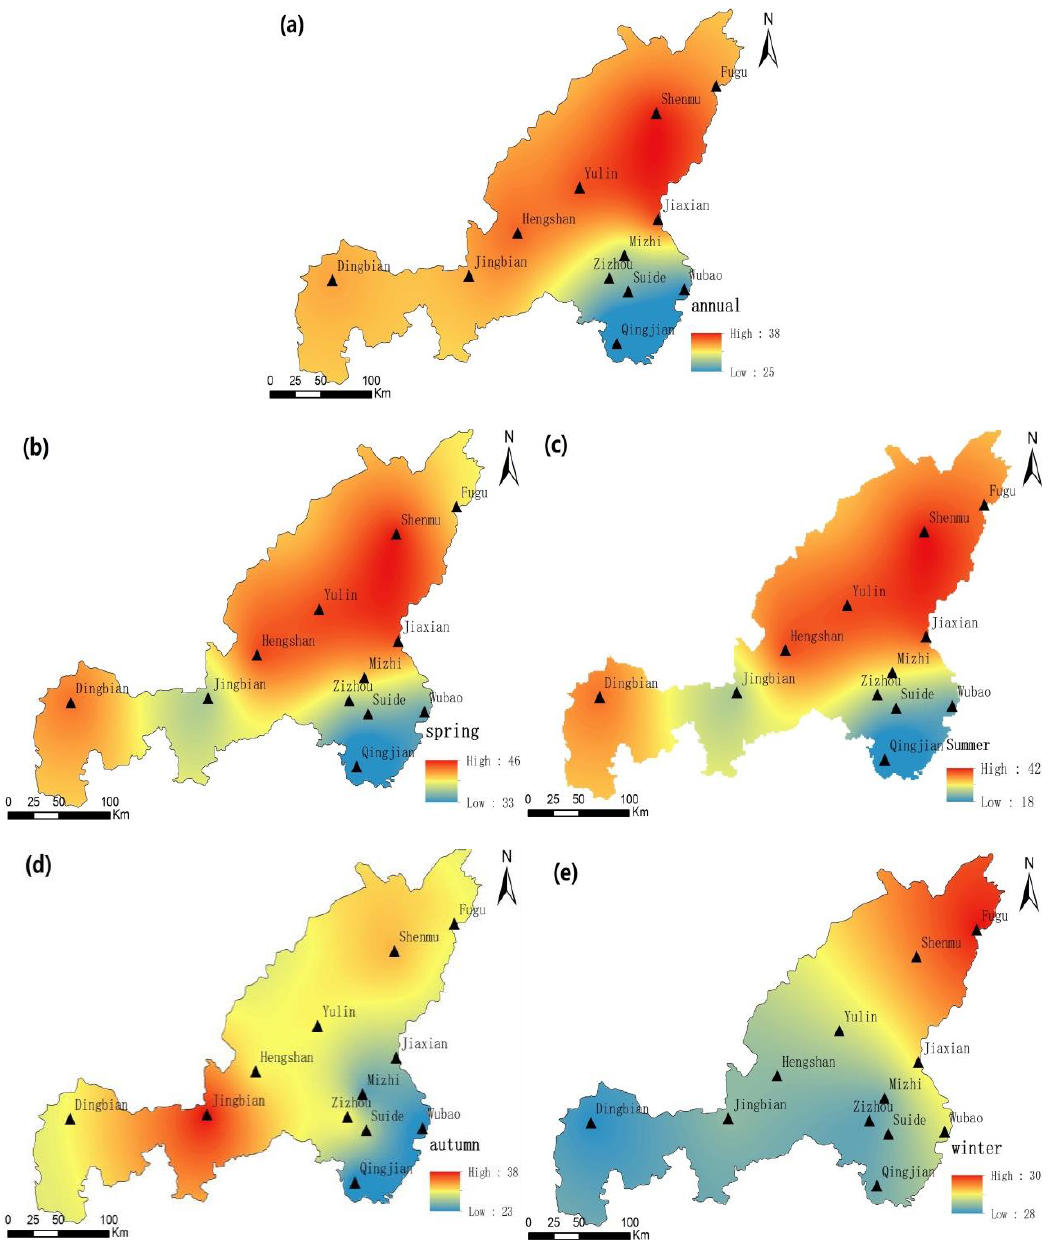
Figure 3. Spatial distribution of annual and seasonal total drought occurrence frequency (%) in Yulin City of northern Shaanxi. ( a ) Annual, ( b ) Spring, ( c ) Summer, ( d ) Autumn, ( e ) Winter.